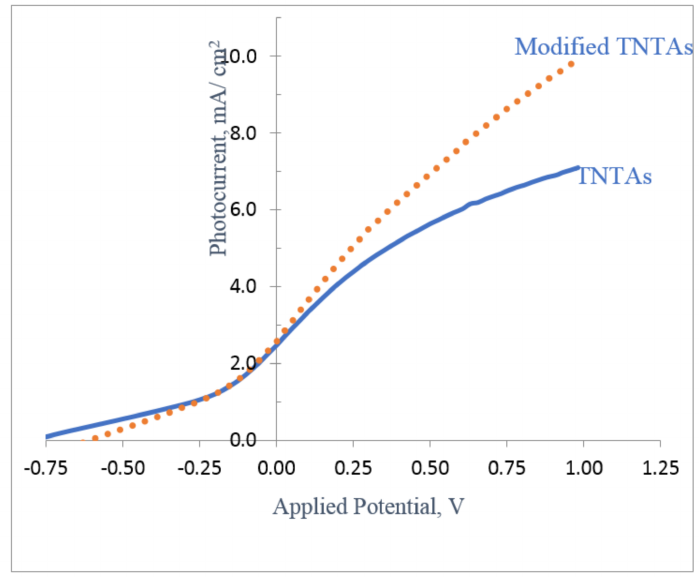
Figure 9. Photocurrent density of modified TNTAs compared with that of pristine (unmodified) TNTAs. Both samples were anodized in the same conditions with identical